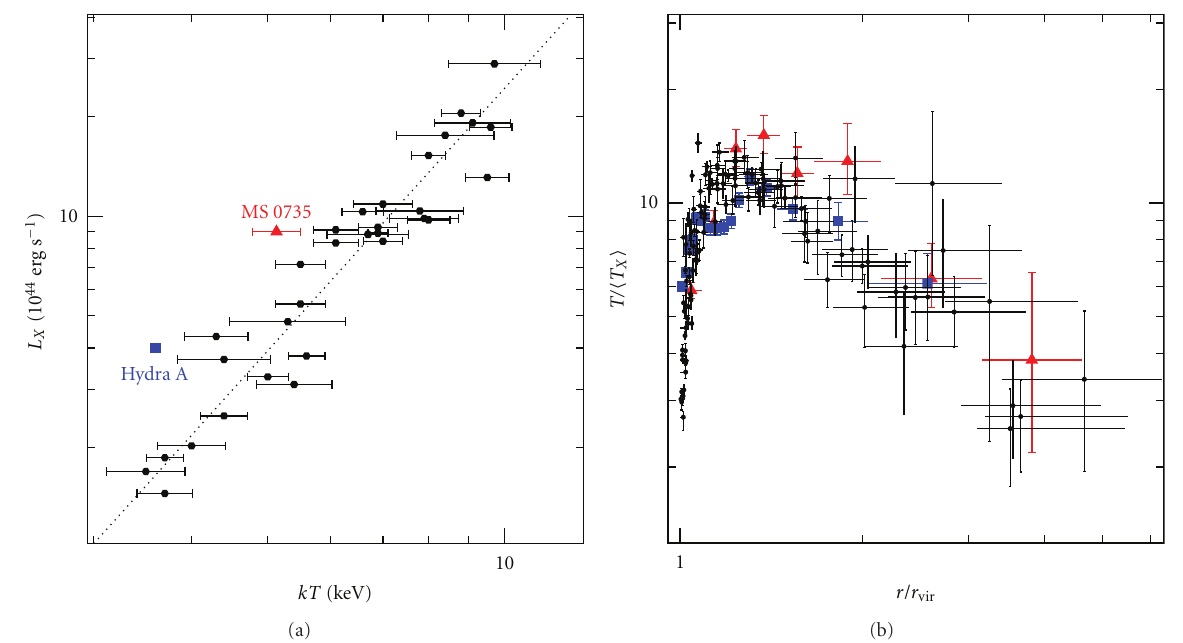
Figure 5: (a) Bolometric X-ray luminosities corrected for the e ff ect of cooling flow in the central ∼ 70 kpc versus emission-weighted temperatures derived excluding cooling flow components, from Markevitch [25]. The dashed line is the best-fit power law to the sample: L X = 6 . 35 · ( kT/ 6 ke V ) 2 . 64 × 10 44 ergs − 1 . The red triangle and the blue square represent the measurements from the XMM-Newton and Chandra data of the giant cavity clusters MS 0735 + 7421 [209] and Hydra A, respectively, corrected consistently with the method adopted by Markevitch [25]. (b) Temperature profiles measured for a sample of relaxed clusters presented by Vikhlinin et al. [79]. The temperatures are scaled to the cluster emission-weighted temperature excluding the central 70kpc regions. The profiles for all clusters are projected and scaled in radial units of the virial radius r vir , estimated from the relation r vir = 2 . 74 Mpc corrected, scaled temperature profiles of the giant cavity clusters MS 0735+7421 (red triangles, Gitti et al. [136]) and Hydra A (blue squares, Gitti et al. [120]).